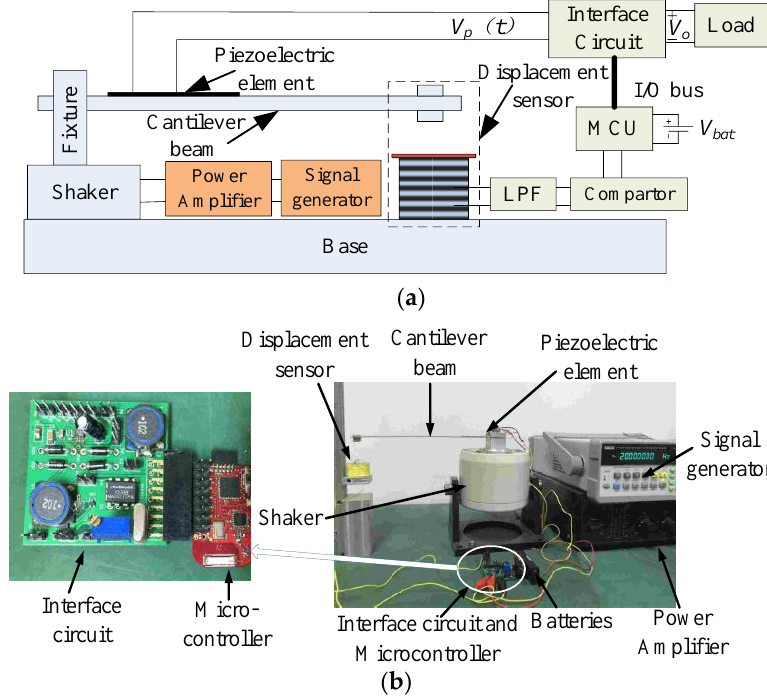
Figure 10. Schematic block diagram and experimental setup. LPF: low-pass filter. ( a ) Schematic block diagram; ( b ) The experimental setup. Table 1. Parameters of the experimental